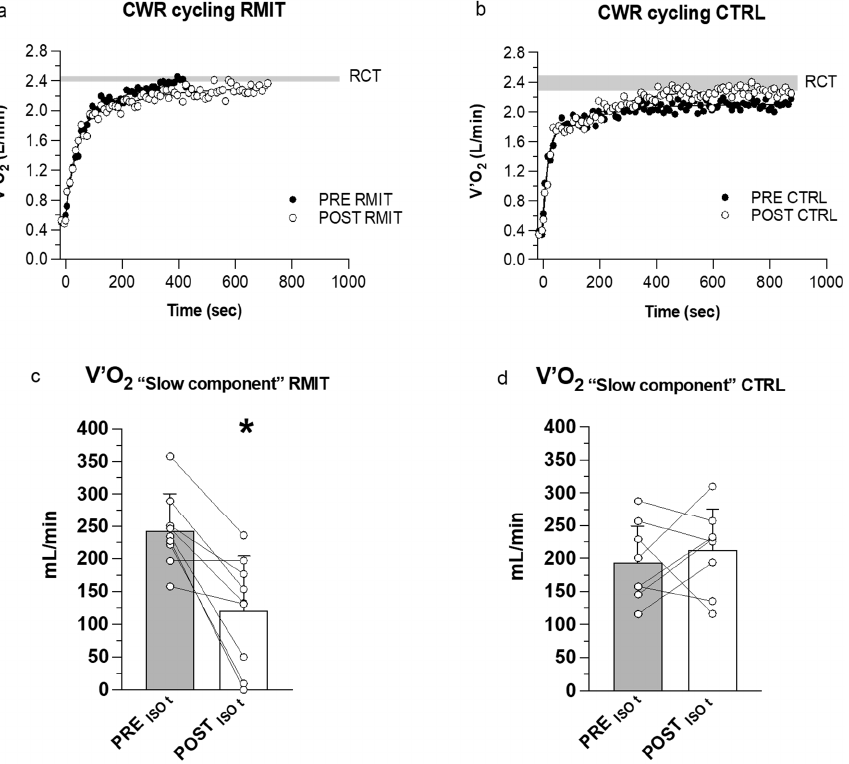
Figure 3. ( a , b ) Representative patterns of